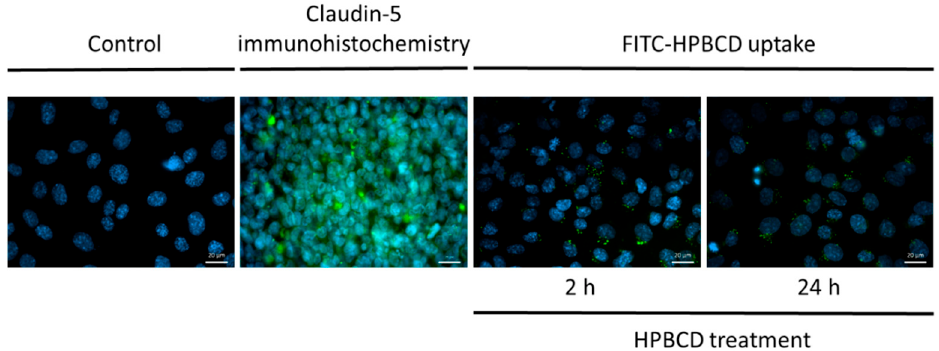
Figure 6. Fluorescence microscopic images of FITC-HPBCD-treated and untreated hCMEC/D3 cells. (Green: claudin-5 immunostaining on immunohistochemistry image and FITC-HPBCD on FITC-HPBCD uptake image; blue: cell nuclei) Bar: 20 µm.